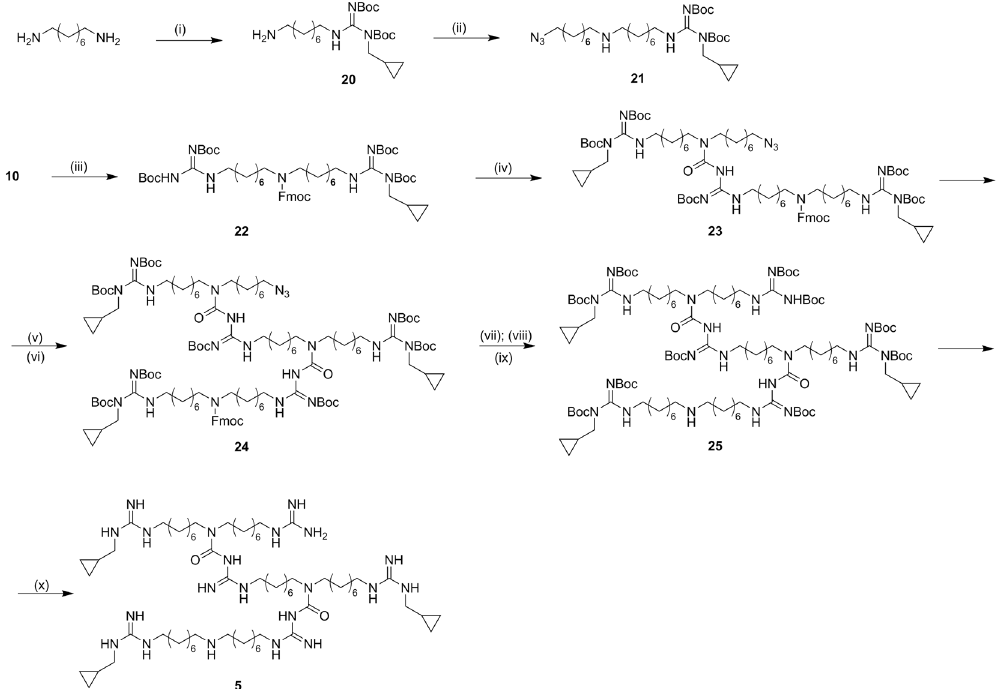
Figure 9. Synthesis of the asymmetric trimer ( 5 ). Reagents and condition: (i) N,N ′ -Di-Boc- N - methylcyclopropyl-pyrazole-1-carboxamidine, DIPEA, CH 3 CN/CH 3 OH, 50 °C, 16 h; (ii) CsOH·H 2 O, molecular sieves, 6 , dry DMF, r.t., 24 h; (iii) FmocCl, DIPEA, dry DCM, 0 °C to r.t., 2 h; (iv) 21 , TEA, THF, ref., 10 h; (v) Piperidine 20%, DMF, r.t., 1 h; (vi) 22 , TEA, dry THF, ref., 16 h; (vii) H 2 , Pd/C, i- PrOH, r.t., 1.5 h; (viii) N , N ′ -Di- Boc-1 H -pyrazole-1-carboxamidine, DIPEA, THF, r.t.,16 h; (ix) Piperidine 20%, DMF, r.t., 5 h; (x) TFA 10%, dry DCM, r.t., 10